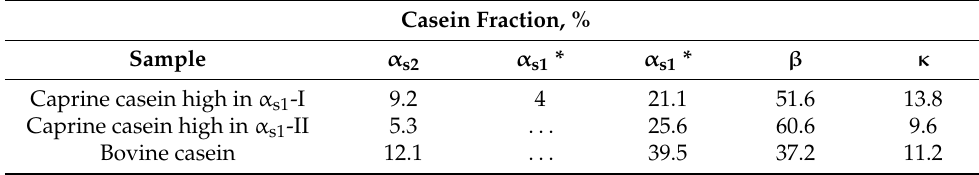
Table 1. Casein distribution of caprine caseins compared with a typical bovine casein 1 .